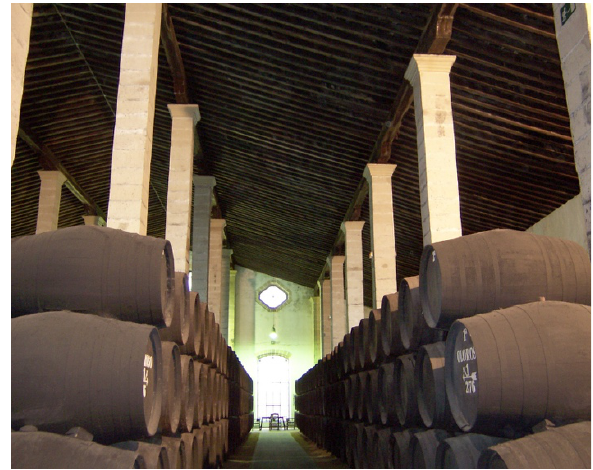
Figure 6. Winery Dios Baco, Jerez de la Frontera. (Aladro- Prieto, 2012).